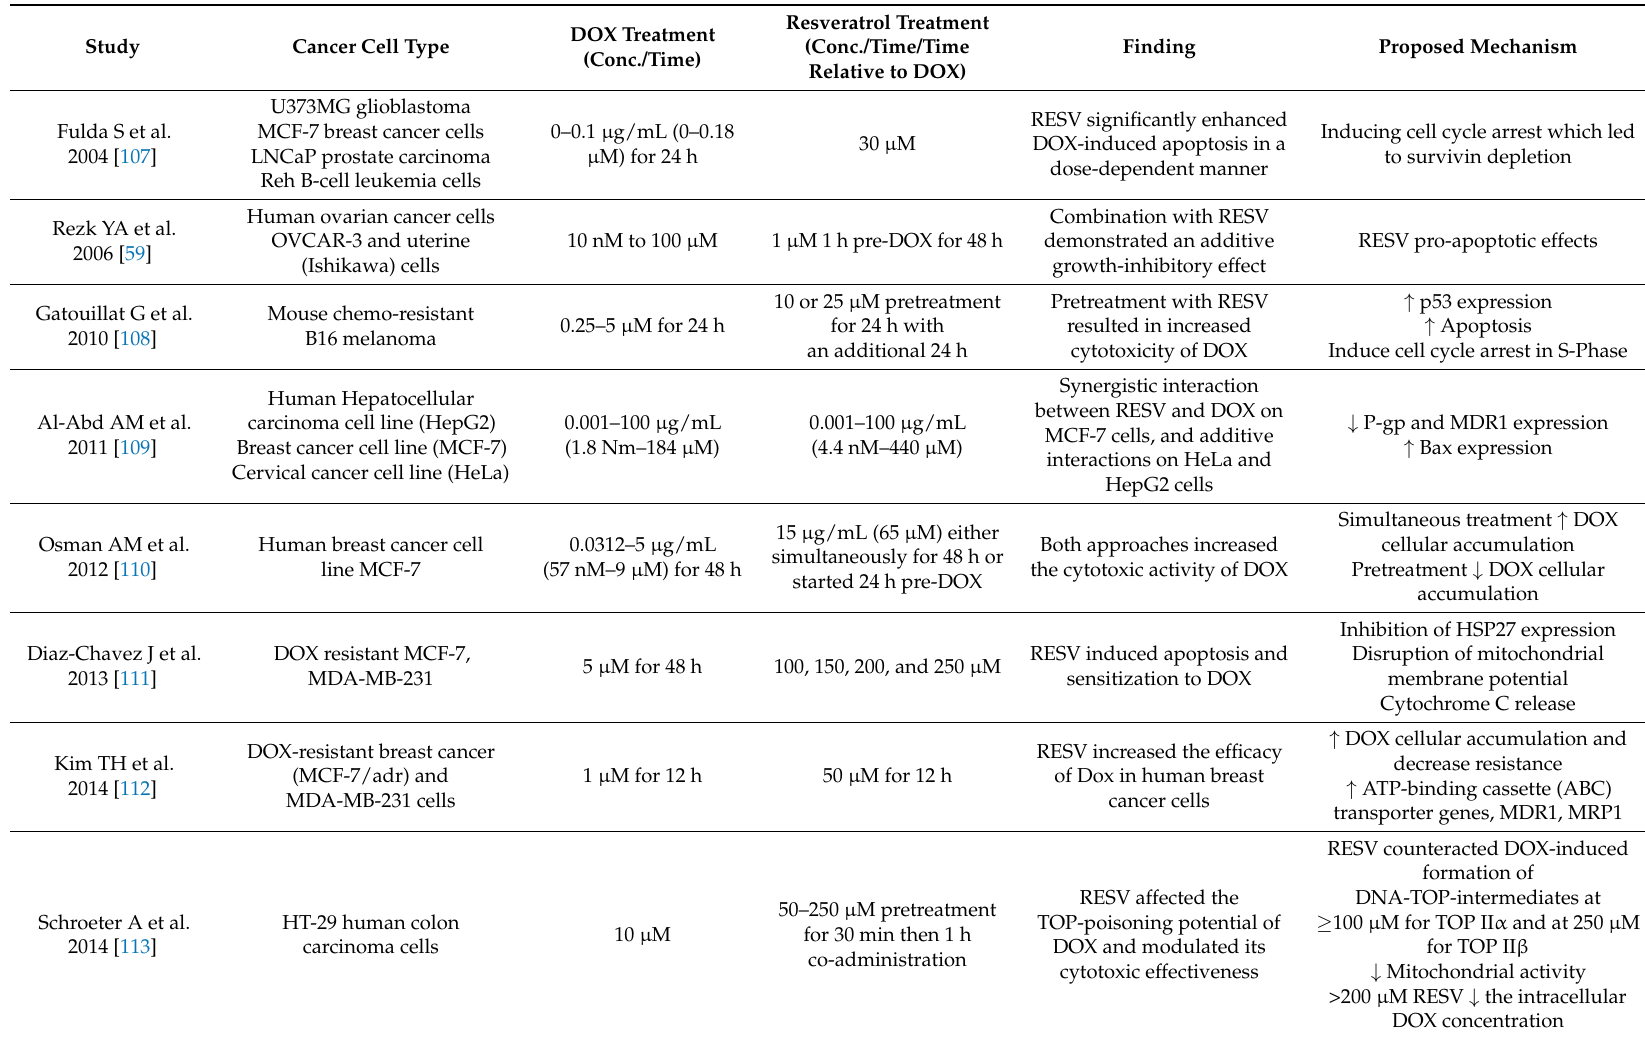
Table 3. In vitro studies demonstrating anticancer effect of the combination of resveratrol and anthracycline